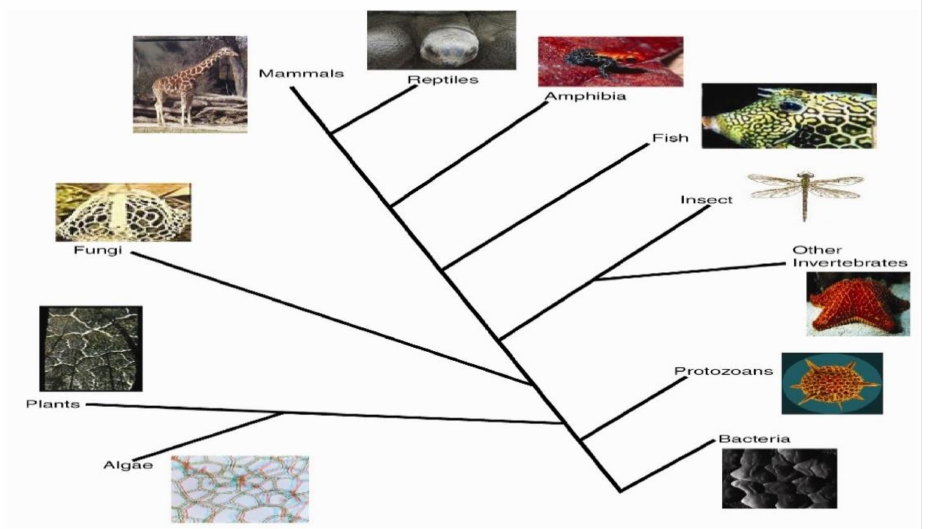
Figure 6. A phylogenetic sampling of species that display Voronoi tessellation patterns on their exterior or in their colonial aggregate. Clockwise from lower left: the colonial algae Hydrodictyon , a canopy of teak trees from Thailand, a lacey stinkhorn fungus, a reticulated giraffe, a Galapagos tortoise, a reticulated frog, a trunkfish, a dragonfly (the wing pattern), a starfish, a radiolarian, and a bacterial biofilm.